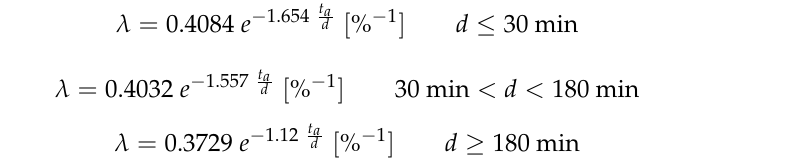
λ = 0.453e ‐ 1.688 (ta/d) R² = 0.9179